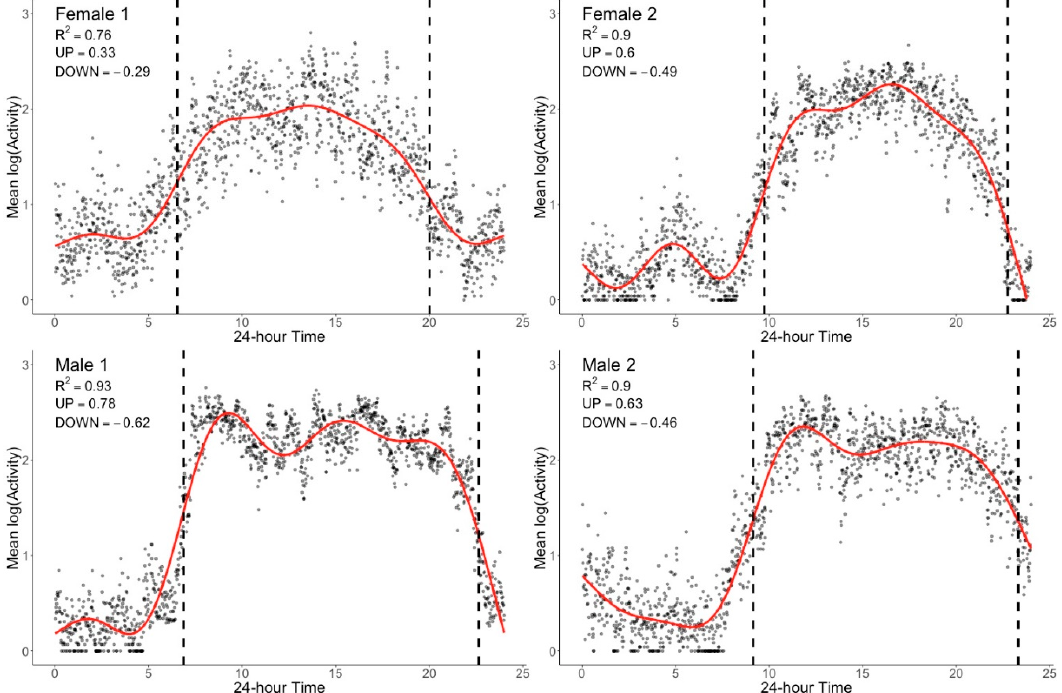
Figure 6. Examples of the smoothed curve (red line) produced by a generalized additive model with aggregated longitudinal actigraphy for the four older adults presented in Figures 1 and 2. R-squared, UP slope and DOWN slope values are presented for each participant, with the dashed lines representing the 24 h time at which the UP and DOWN slopes were calculated (i.e., the time in which the change in activity counts was greatest). It can be seen that the smoothed curves reliably reflect individual changes in activity across the average 24 h period.